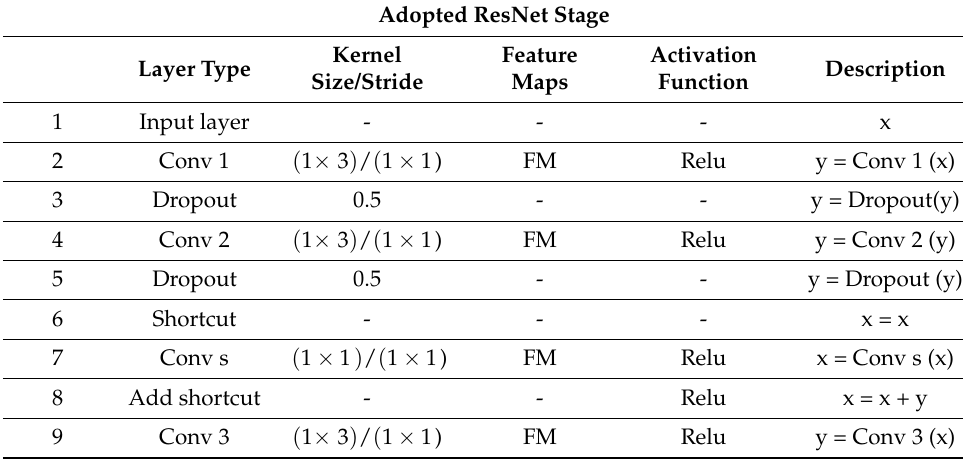
Table 5. Detailed architecture of unit stage of